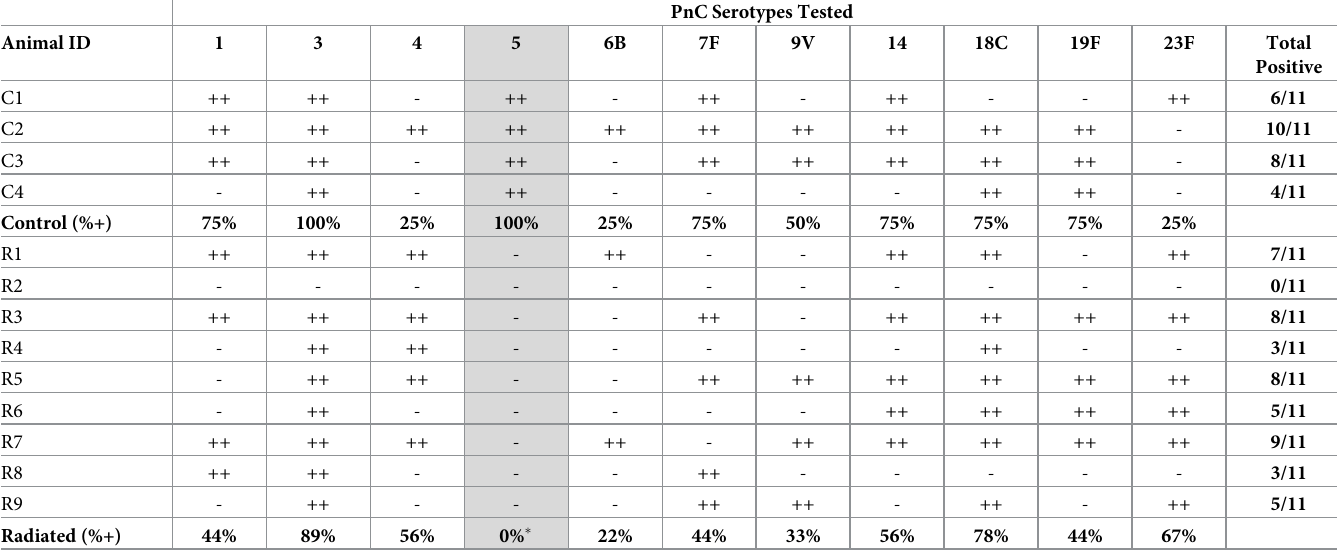
Table 1. Antibody responses to pneumococcal (Pnc) vaccine ~2 years post-irradiation.